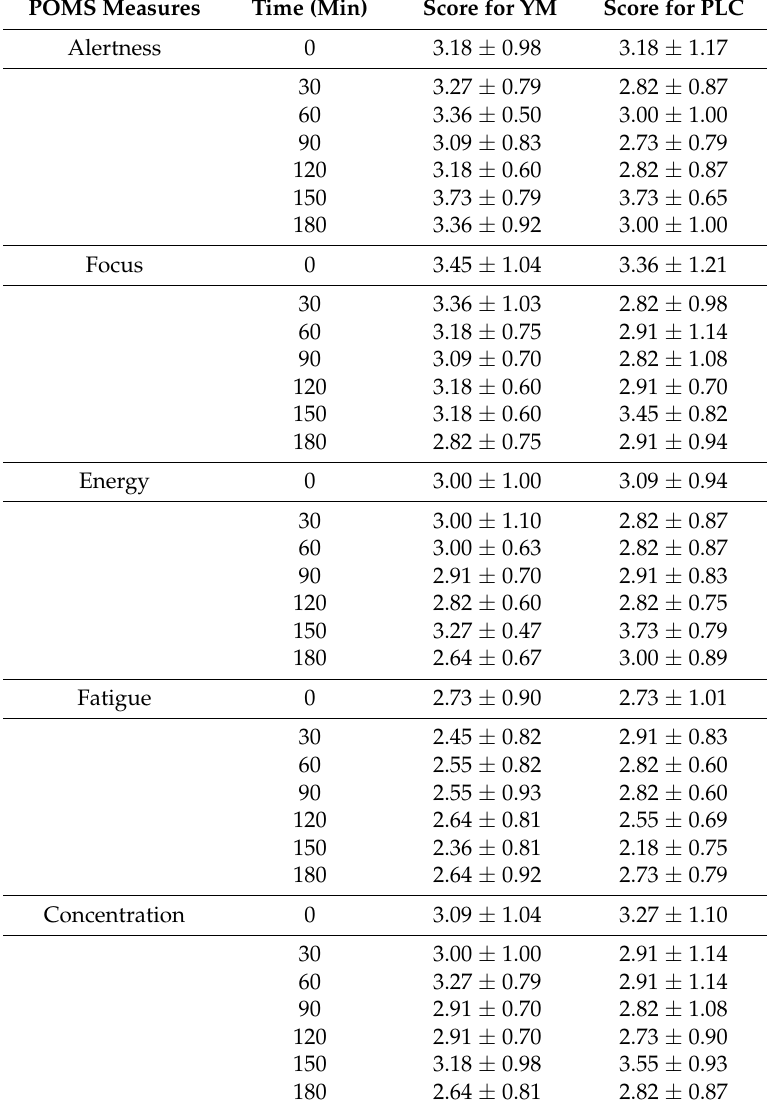
Table 2. Profile of Mood State (POMS) results for Yerba Mate (YM) and placebo (PLC) treatments at different time points, at rest (0–120 min), exercise (120–150 min), and post exercise (180 min). Results displayed as Mean ±